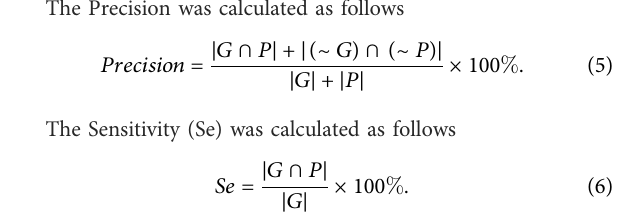
TABLE 3Comparison oflung lobe segmentationresults with other models. Dsc is used as the evaluation standard. RUL RML RLL LUL